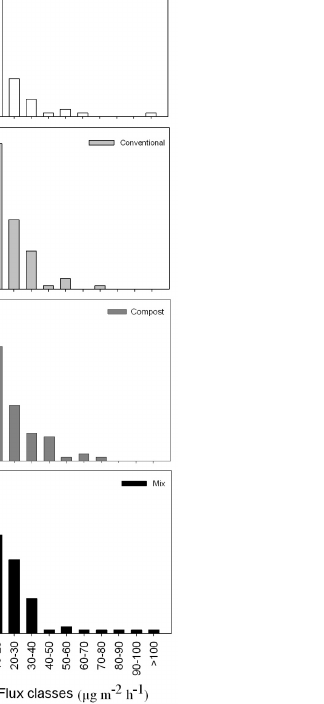
Figure 4. Frequency distribution of N 2 O fluxes measured in the four treatments.